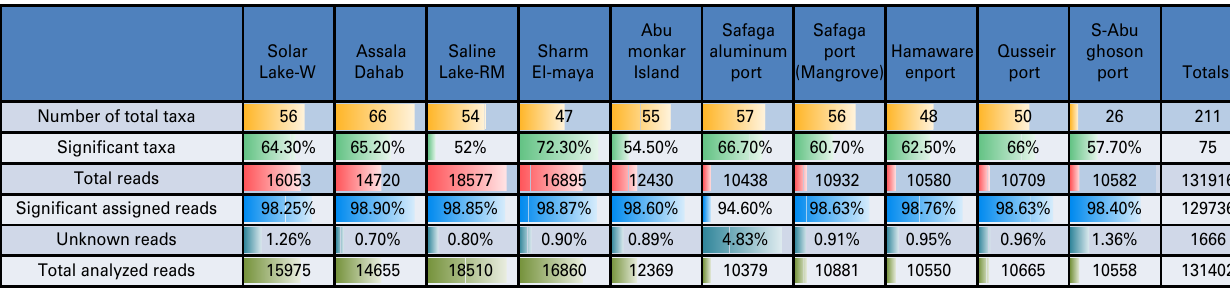
Table 2 | Pyrotag 16S rDNA data set.